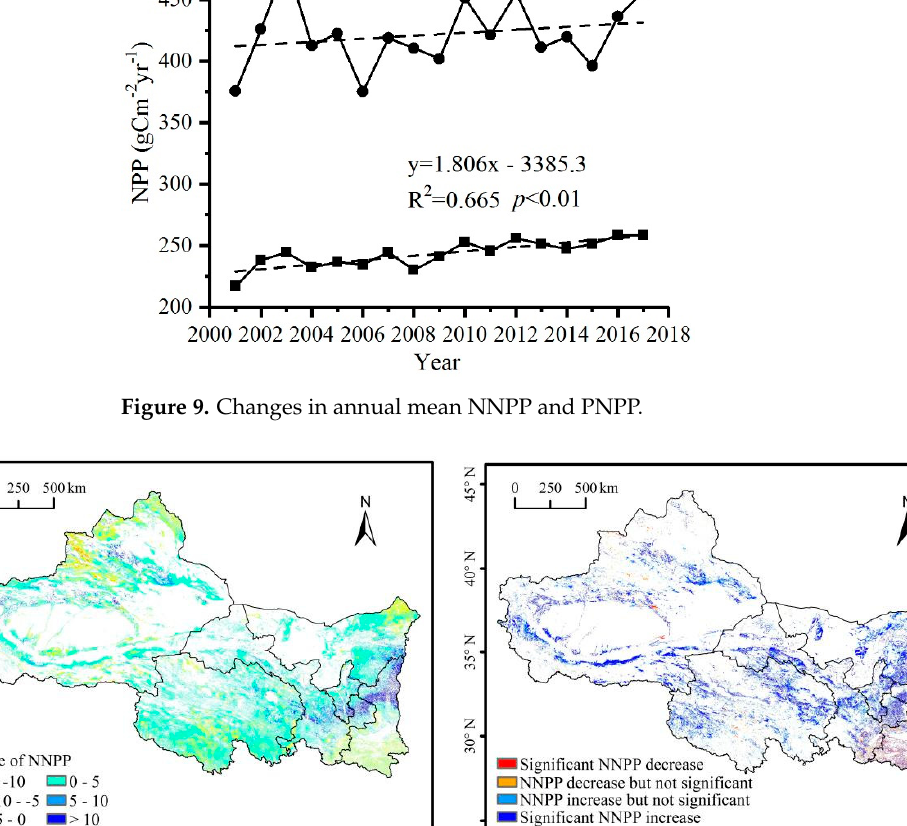
Figure 10. Interannual changing rate and significance of NNPP.